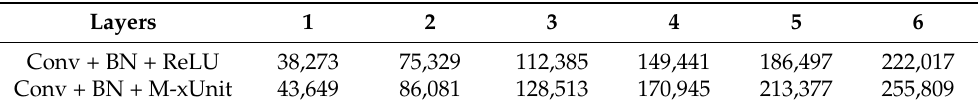
Table 2. Network parameters for different